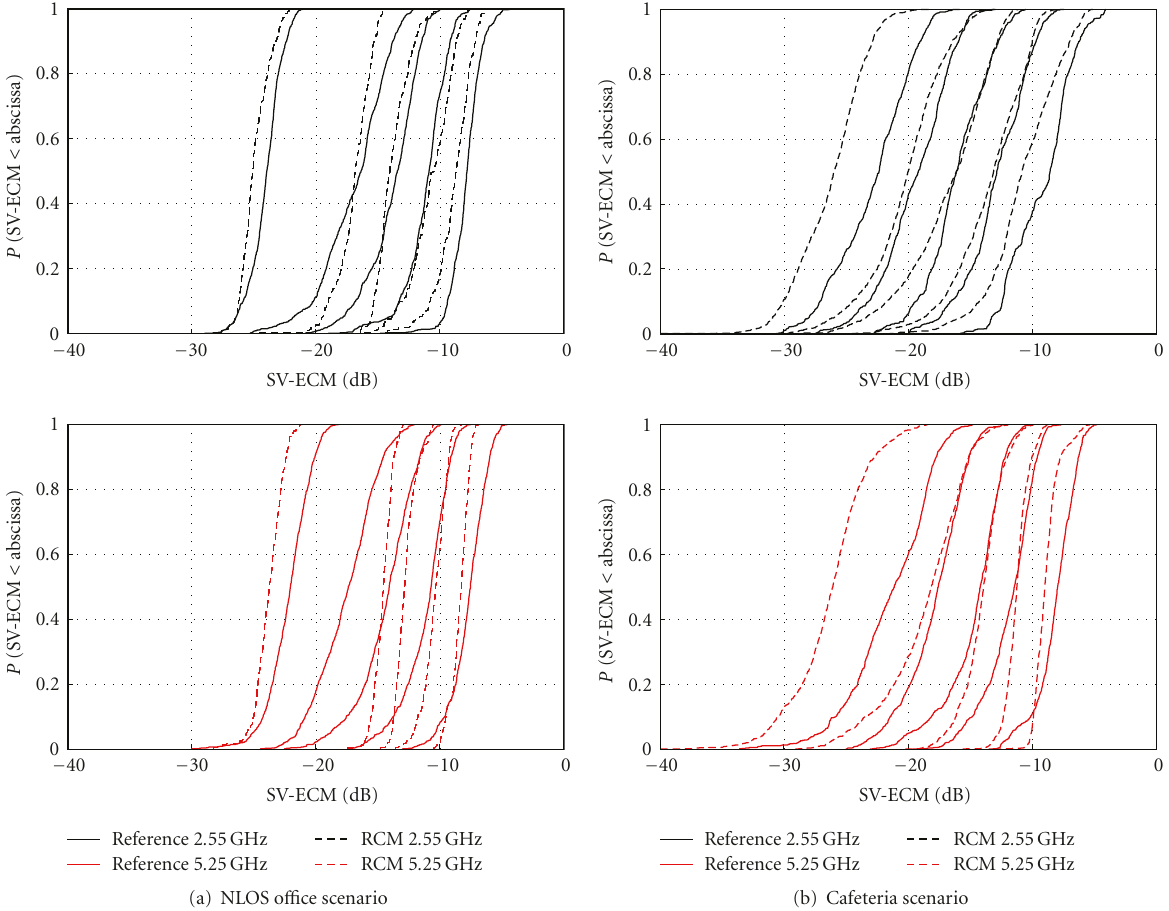
Figure 6: Model validation using the Environment Characterisation Metric. Shown are the distributions of the five singular values of the ECM.